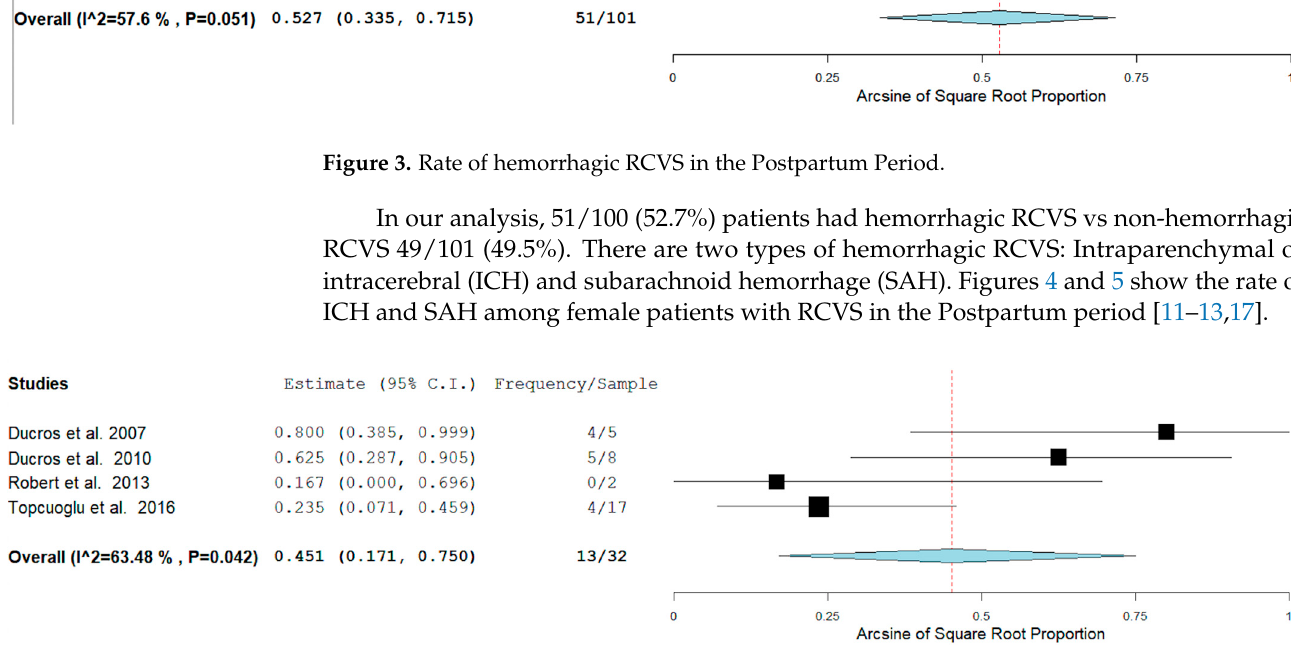
Figure 5. Rate of SAH among females with RCVS in the Postpartum Period. The rates of ICH and SAH were 51.6% and 10.7% respectively. ICH seems to be more common than SAH as a hemorrhagic complication. Bias Analysis The study by Patel et al. was limited because the retrospective design of this study causes selection bias. Additionally, it was done with hospitalized patients and did not consider outpatient settings, which could lead to misdiagnosis, delayed diagnosis, and the underestimation of true incidence. Finally, there were administrative reporting errors in the International Classification of Diseases-10 codes for RCVS [17]. Inconsistent imaging timing limited Tocuoglu et al.’s study model, and thus subacute findings may be biased toward symptomatic lesions. Besides, iatrogenic factors may in- fluence lesion development and were not considered in the study [14]. Robert et al.’s study was limited by the retrospective design and the small cohort of patients [13]. Ducros et al.’s study was not free of bias because it was a prospective single-center observational study. They did not blind the observers of the neuroimaging data to the study’s hypothe- ses or the clinical status of the patient’s [12]. Boitet et al.’s study was limited because there were no regular prespecified intervals for the follow-up, and there was no standardized imaging paradigm for recurrent head- aches. There is also an underestimation of the rate of R-RCVS because of a lack of system- atic vascular imaging and blinding of the observers of neuroimaging data. Moreover, the study did not assess patients that avoided vasoconstrictors, so they could not calculate the relapse rate [15]. There were some limitations in De Boysson et al.’s study as well. Complete data re- trieval is limited by a retrospective study design. The two cohorts (only French popula- tion) show differences from other published series, limiting the results’ extrapolation. Ad- ditionally, only reported patients were selected for the study, so it did not reflect real-life practice [16]. Finally, in the study by Ducros et al., the rate of RCVS was underdiagnosed because it was a single prospective center observational study with a small sample [11].